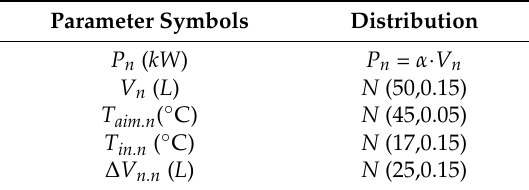
Table 1. Domestic electric water heater system parameters’ probability